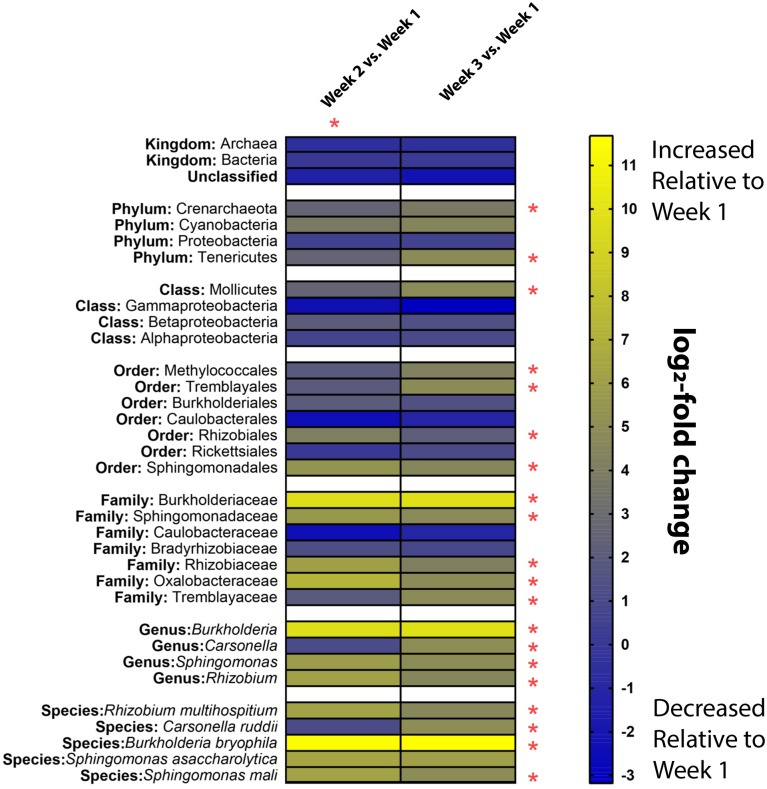
A comparison of fold-change of taxa found in ambulances relative to first sampling event.Heatmap illustrating the log2-fold change of organisms sequenced using ONT MinION relative to the first week of sampling. Yellow squares correspond to an increase in a given taxa at a corresponding week relative to Week 1, while blue squares indicate a decrease in abundance of a taxa relative to Week 1. Asterisks indicate a significant change relative to Week 1 (p<0.05). All changes from week 2 are significant relative to week 1 as indicated by the red asterisk.